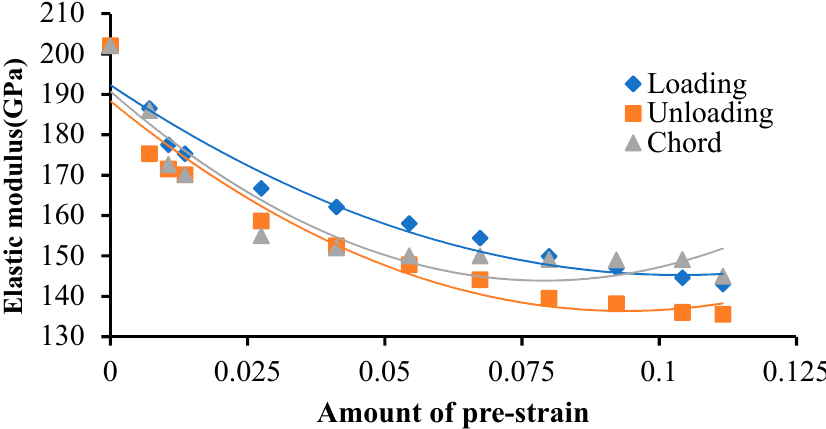
Figure 4. Elastic modulus evolution with pre-strain for st-37. Table 1. Yoshida equation’s parameters for st-37.